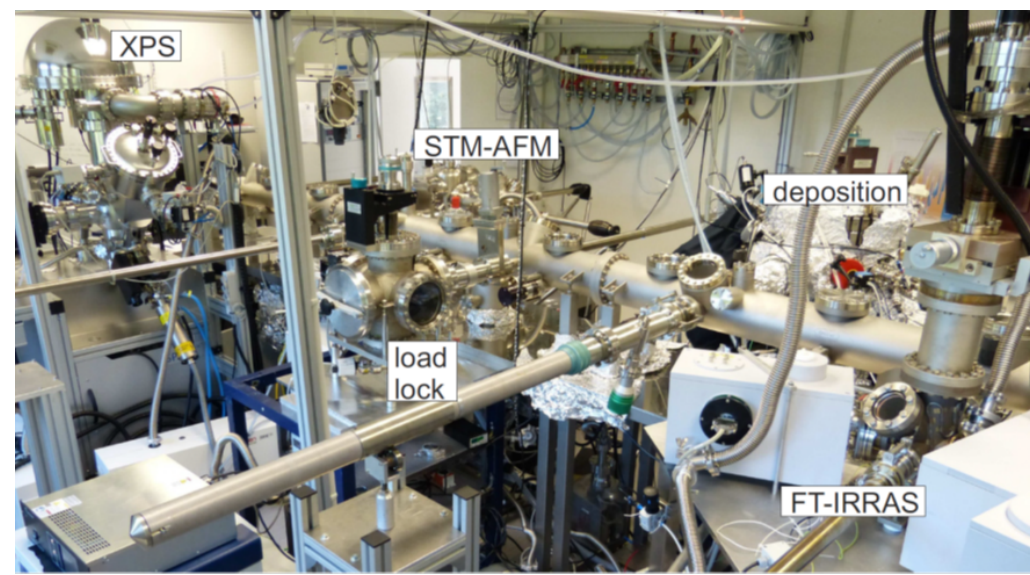
Figure 1: Multi method UHV lab as part of the DESY